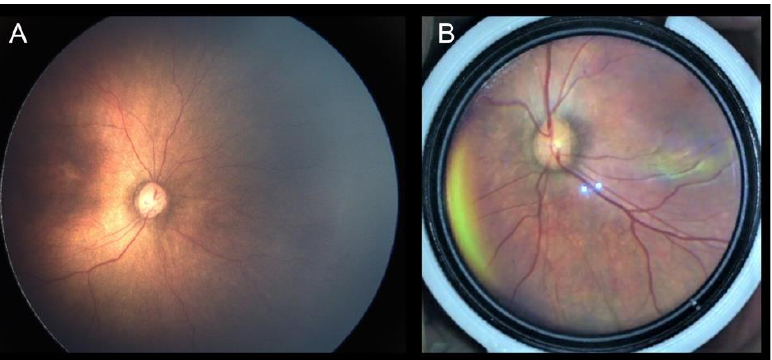
Figure 3. Examples of images taken by the different modalities. ( A ) RetCam. ( B ) C3 Funduscam.